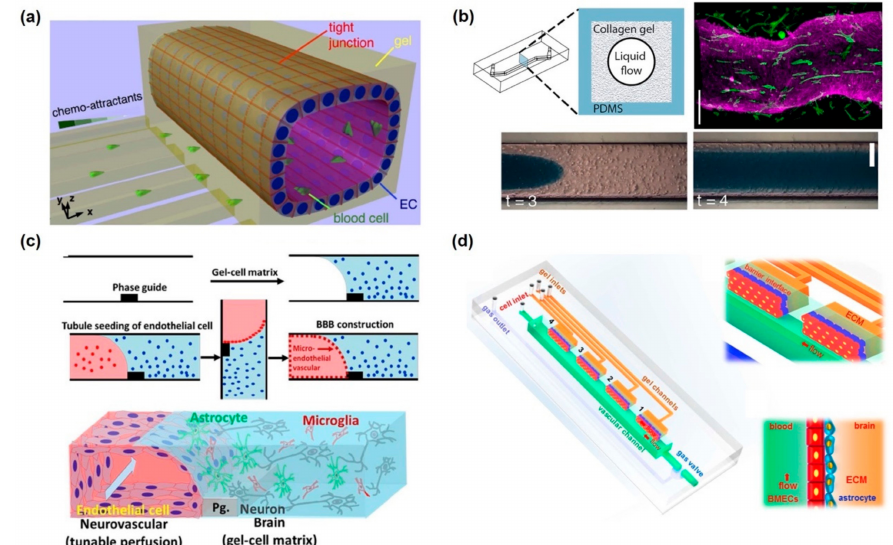
Figure 5. In vitro microfluidic-integrated neurological disorder models. ( a ) 3D model of BBB on a microfluidic platform with microglia cells for observation immune-reaction of the TNF- α -mediated neuroinflammation. Reproduced with permission from [94]. Copyright 2015, Springer Nature. ( b ) Tubular structured neurovascular unit by pressure-driven viscous fingering method. It is stimulated by TNF- α for emulating neuroinflammation. Reproduced with permission from [95]. Copyright 2016, PLOS. ( c ) Horizontal-aligned neurovascular unit for organophosphate (OP) toxicity screening by 3D tetra-culture for brain on chip. Reproduced with permission from [96]. Copyright 2018, Springer Nature. ( d ) Horizontal-aligned neurovascular unit for brain metastasis. Each unit of this device consists of four uniform BBB regions, one vascular channel, one gas channel, one gas valve and four gel channels. Reproduced with permission from [97]. Copyright 2016 Springer